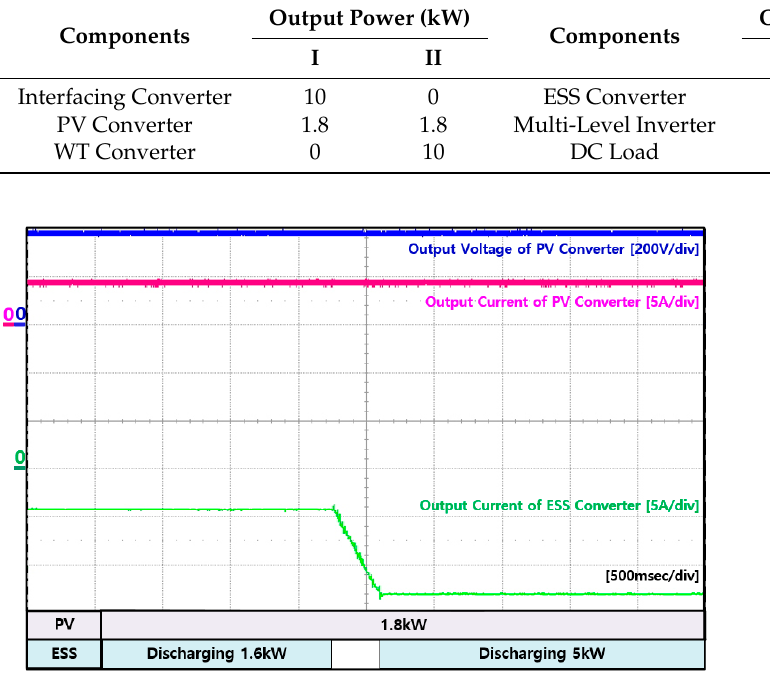
Figure 39. Experiment waveforms of PV converter and ESS converter in mode 9.